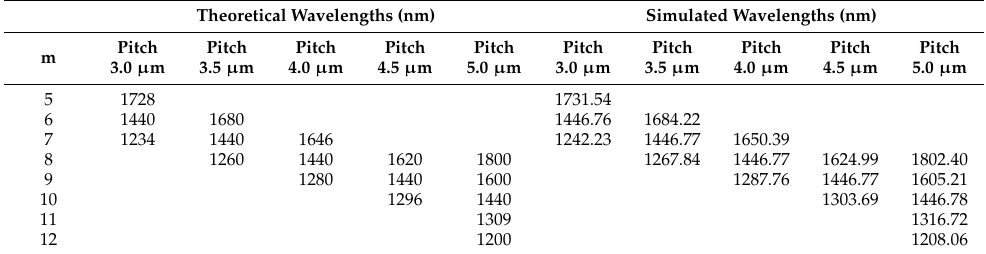
Table 1. Theoretical (left) and simulated (right) wavelengths for the FBG